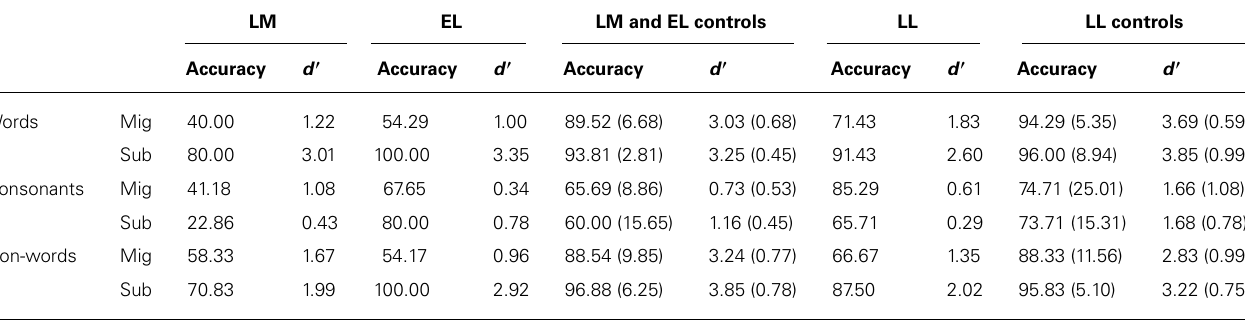
Table 4 | Percentage accuracy for the different migration (mig) and substitution (sub) conditions on the same-different decision task, and d (cid:2) scores.